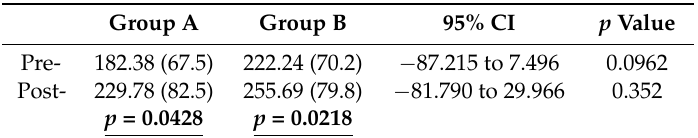
Table 4. Caspase-cleaved K18 levels in plasma [units per litre mean (SD)] between subgroups A and B and between baseline and post-supplementation time points.